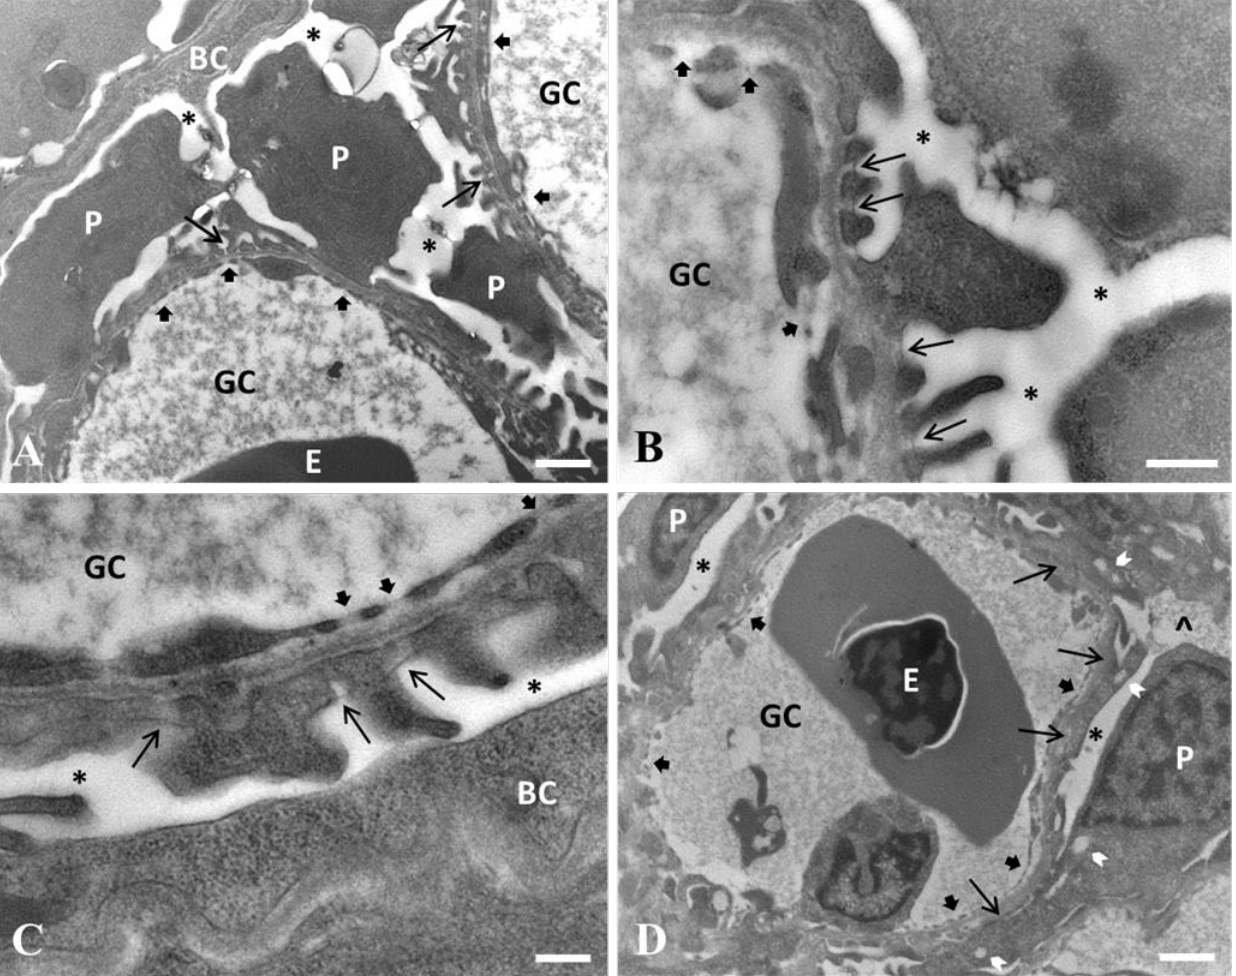
Figure 1. Transmission electron micrographs of the glomerular filtration barrier in unexposed carp ( A , B ), carp exposed to PFOA 200 ng L −1 ( C ), and carp exposed to 2 mg L −1 ( D – F ). ( A ) The normal architecture of the glomerular filtration barrier is shown. The large bodies of podocytes (P) are appreciable, along with the typical interdigitated finger-like tertiary foot processes (pedicels) (thin arrows), contacting the underlying basement membrane, interposed between the foot processes and the fenestrated endothelium (large arrows) of glomerular capillaries (GC). (BC) Bowman’s capsular epithelium. (E) Erythrocyte. (*) Urinary space. Scale bar = 1 µm. ( B ) The slit diaphragm is appreciable